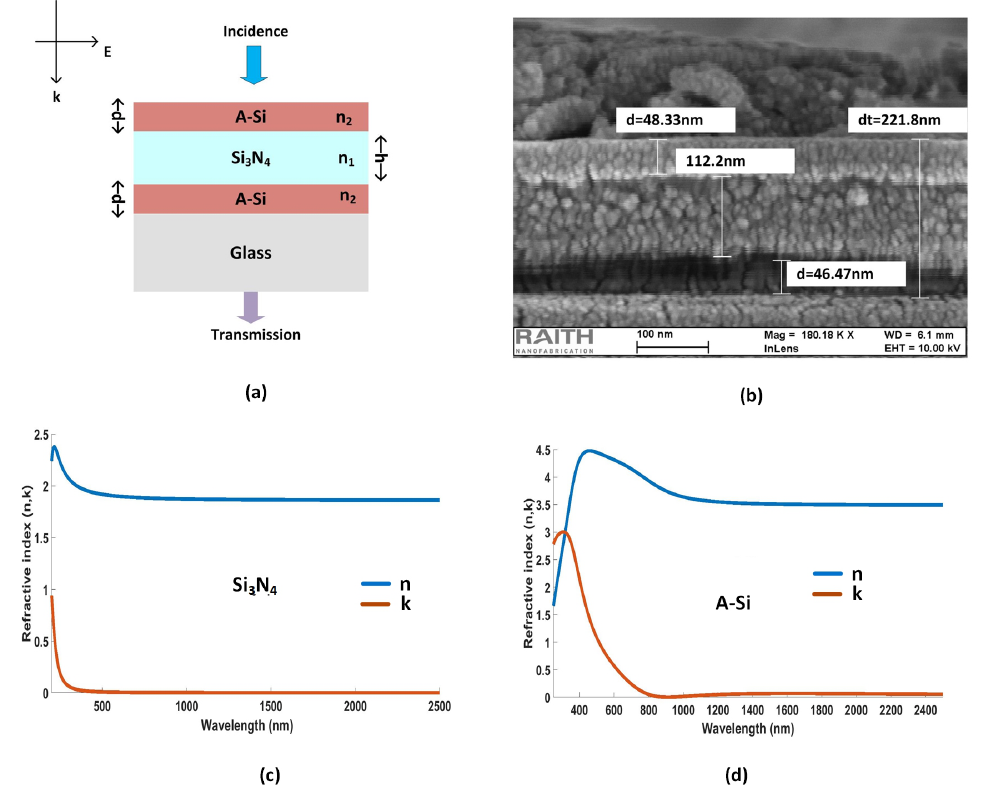
Figure 2. ( a ) A hybrid etalon when cavity thickness d u = d l = d = 40 nm and h = 100 nm. ( b ) SEM image of hybrid etalon. ( c ) Refractive indices of silicon nitride (Si 3 N 4 ); and ( d ) amorphous silicon